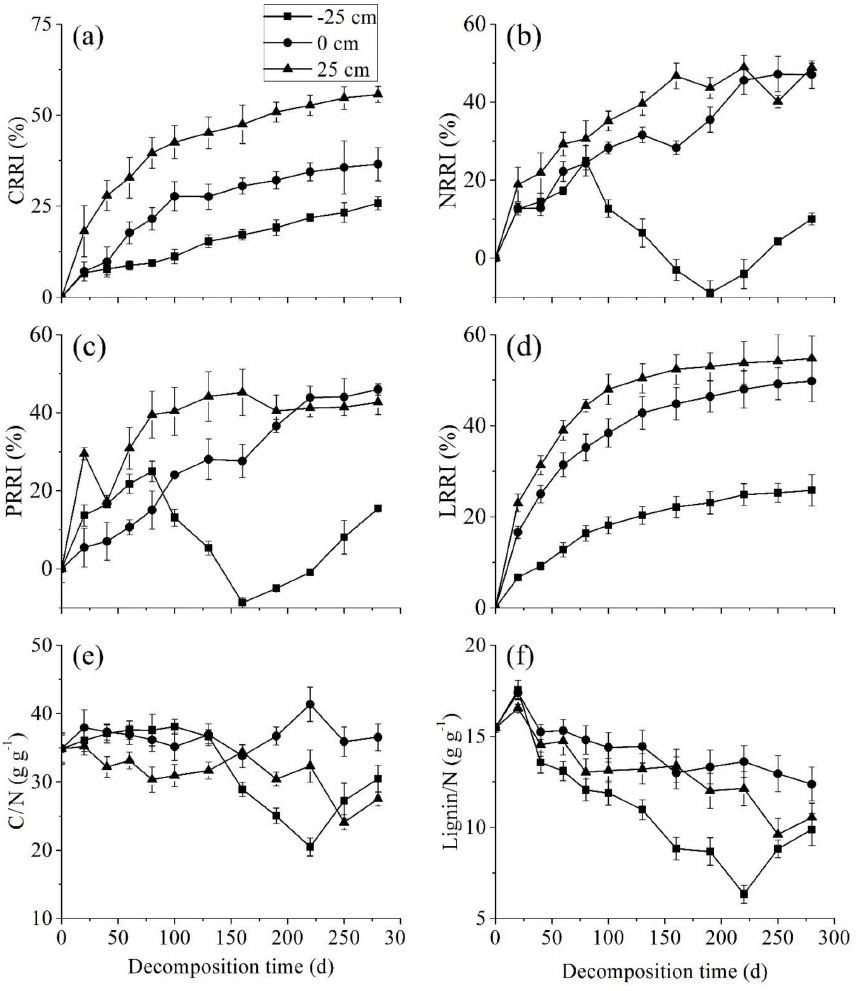
Figure 3. Percentage (mean ± SE) of carbon relative release index (CRRI), nitrogen relative release index (NRRI), phosphorus relative release index (PRRI), lignin relative release index (LRRI), C / N ratio, and lignin / N ratio at three water levels ( − 25, 0, and +